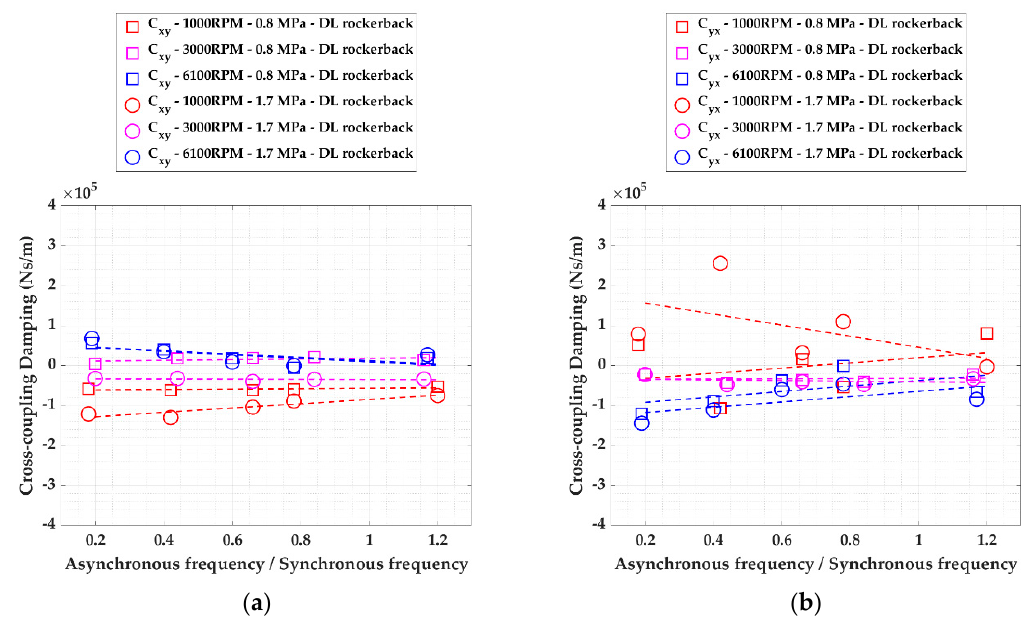
Figure A8. Direct Lube Rocker Pivot bearing asynchronous cross-coupling damping coefficients at various speeds for 0.8 MPa and 1.7 MPa: ( a ) C xy , ( b ) C yx .